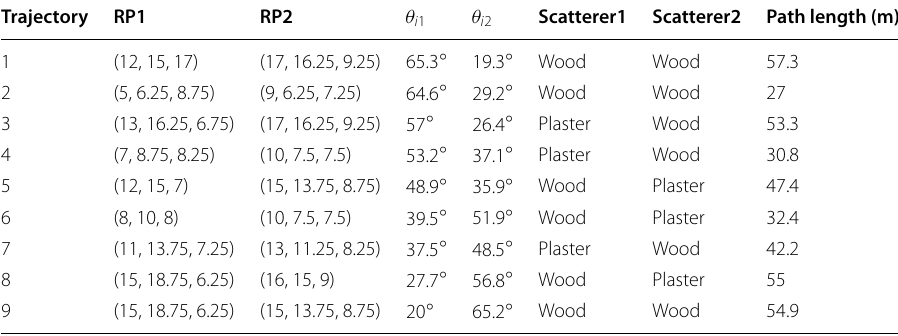
Table 4 Information about possible trajectories and scatterers after matching the measured RL Trajectory